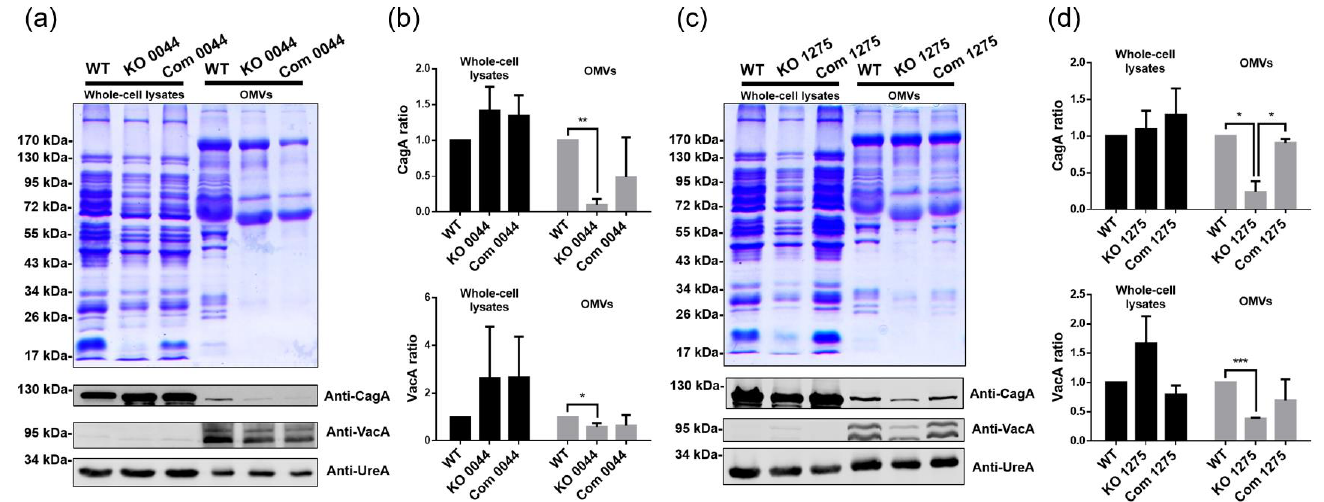
Figure 7. Effects of the HP0044- and HP1275- disrupted mutations on protein sorting into OMVs. ( a , c ), comparison of protein profiles and CagA, VacA and UreA protein levels between the whole-cell lysates and OMVs in different strains of H. pylori . ( b , d ), statistical analysis of the CagA and VacA content. CagA, VacA and UreA were quantified using ImageJ software and normalized to UreA. The data presented were derived from triplicate trials with statistical analysis (unpaired, two-tailed Student’s t -test; * p < 0.05, ** p < 0.01 and *** p < 0.001). Proteins from the whole-cell lysates and OMVs were analyzed by 15% SDS-PAGE with Coomassie blue staining and immunoblotted using anti-CagA, anti-VacA and anti-UreA antibodies. WT, wild-type strain; KO, knockout mutant; and Com, knockout complementary mutant.